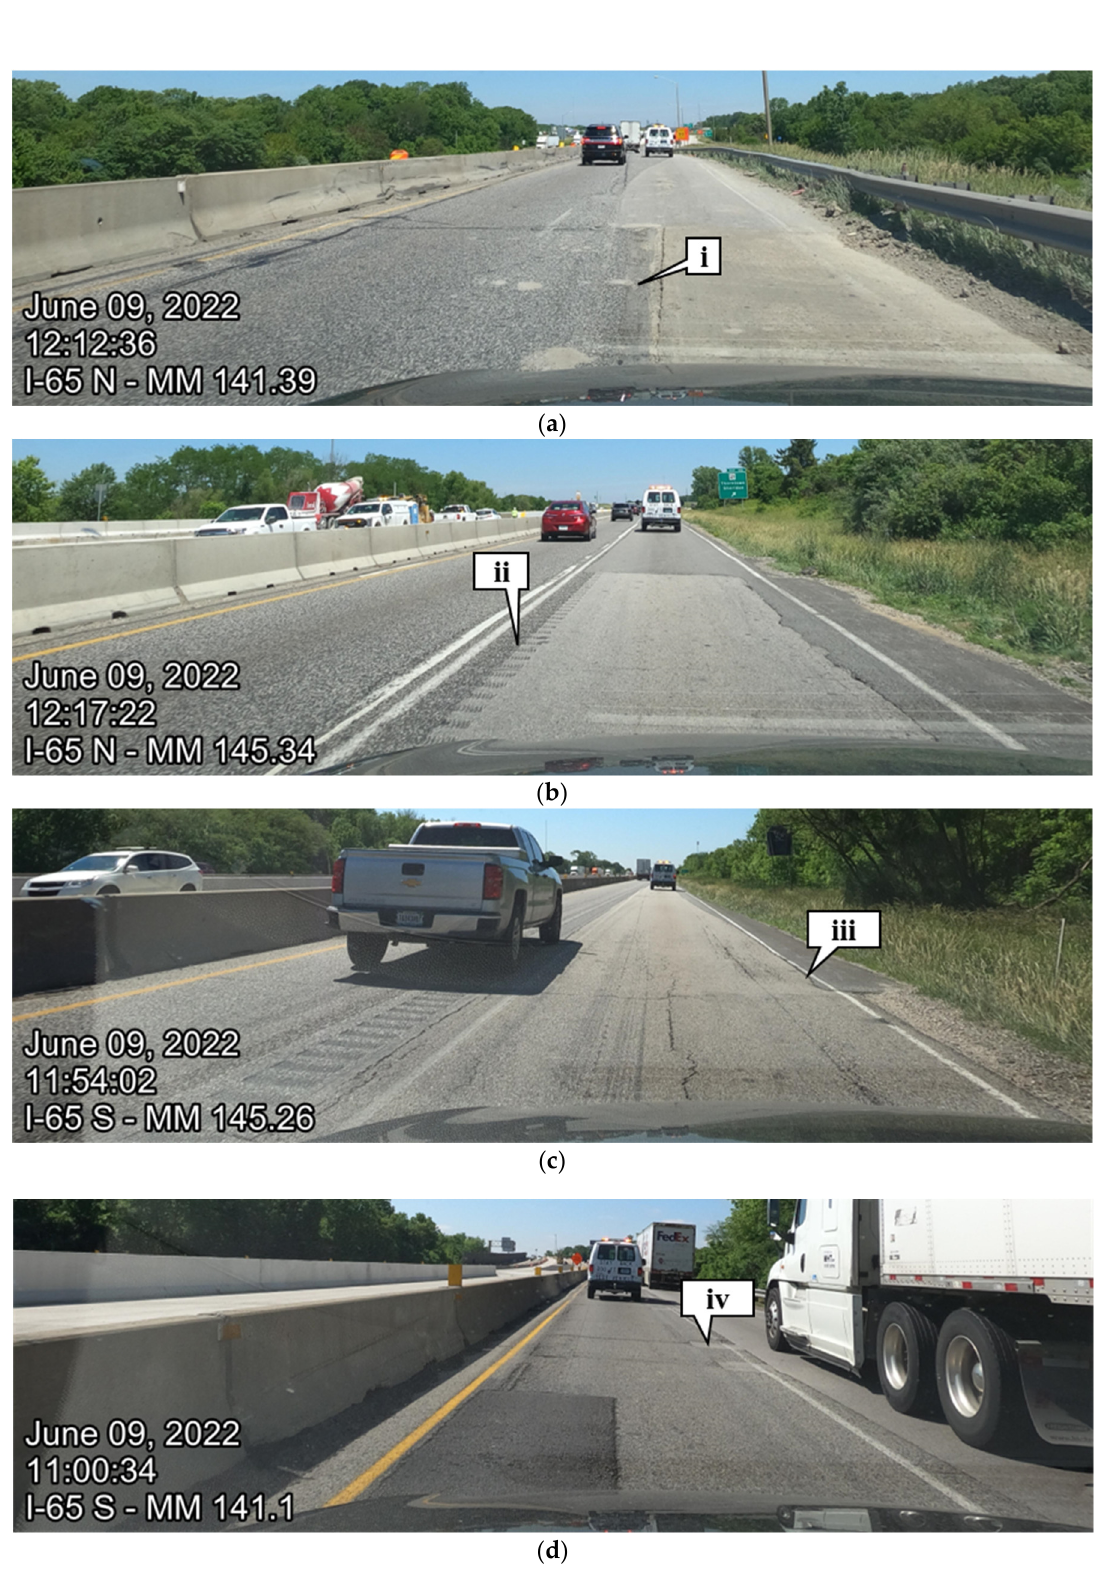
Figure 11. I-65 pavement distress validation points: ( a ) I-65 northbound reference marker 141.3; ( b ) I-65 northbound reference marker 145.3; ( c ) I-65 southbound reference marker 145.3; ( d ) I-65 south- bound reference marker 141.1. Callout (i) pavement spotting; (ii) rumble strips in driving lane; (iii) depression in pavement; (iv) pothole.